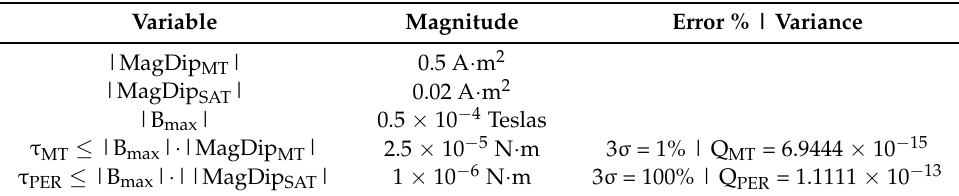
Table 1. Magnitudes of actuation and perturbation in the satellite